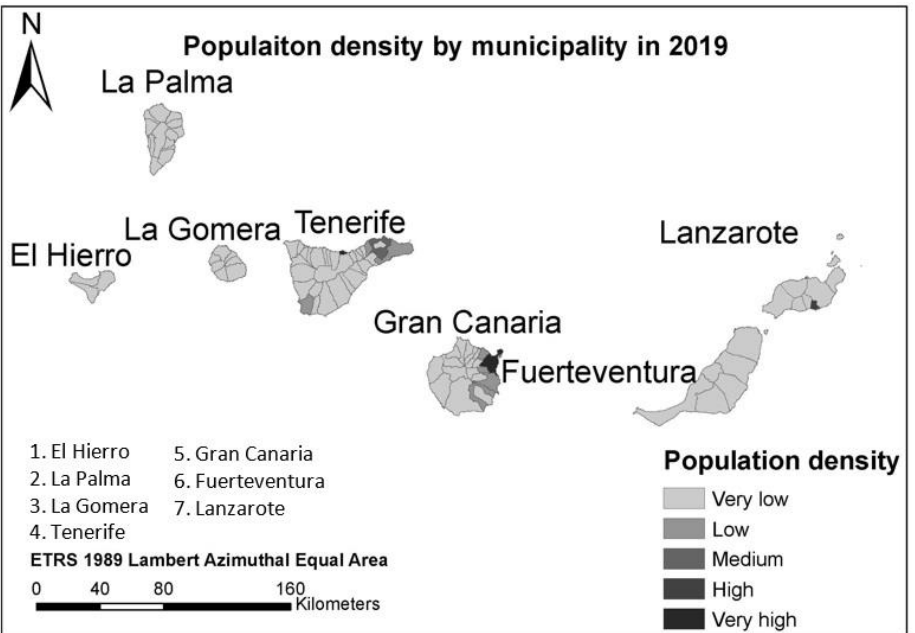
Figure 4. Population density map by municipalities of the Canary Islands (Source: [36]).